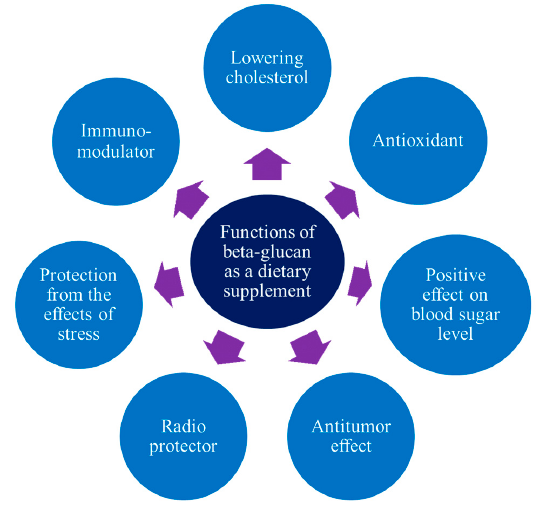
Figure 2. Functional properties of the β -glucan of various types.